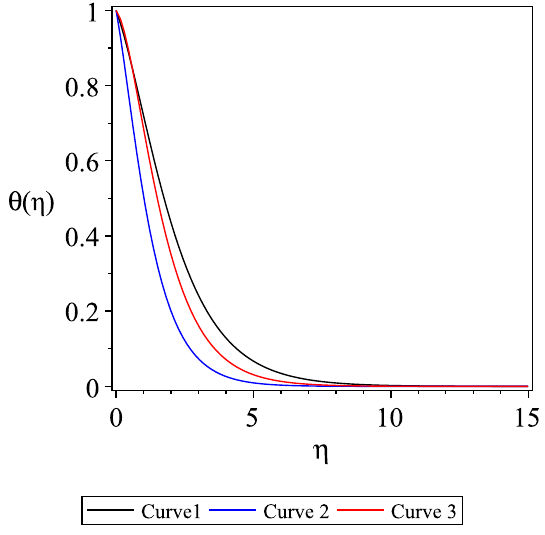
Fig. 7 Plot of (cid:98) θ ( η ) , where Curve 1 has Le = 2, Nb = 2, Pr = 1, Nt = 1, n = 0 . 5, Curve 2 has Le = 3, Nb = 1, Pr = 5, Nt = 0, n = 1, and Curve 3 has Le = 2, Nb = 2, Pr = 7, Nt = 0 . 5, n = 0 . 8 using their respective error-minimizing convergence control parameter.